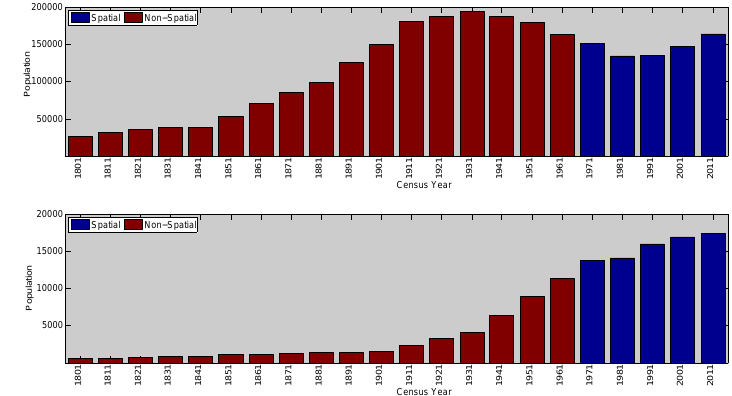
Figure 4. Population time series and source (spatial or non-spatial) for Portsea (above) and Hayling (below).